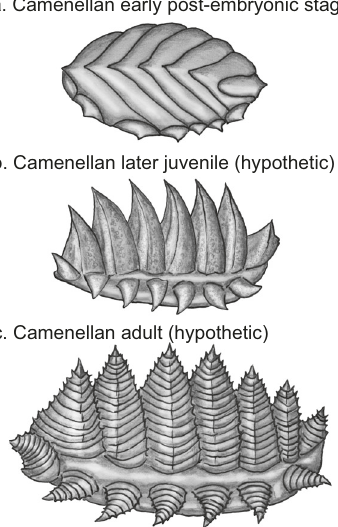
Fig. 6 Reconstruction of dorsal morphology in camenellans. a Interpretative reconstruction of camenellan early postembryonic developmental stage with six central-arched shallow ridges and six pairs of strongly asymmetric lateral protuberances of peripheral zone. b Hypothetical reconstruction of dorsal scleritome in juvenile camenellan before onset of biomineralization in sclerites. c Hypothetical reconstruction of dorsal scleritome in an adult camenellan with biomineralized sclerites organized in a medial and a peripheral concentric zone.